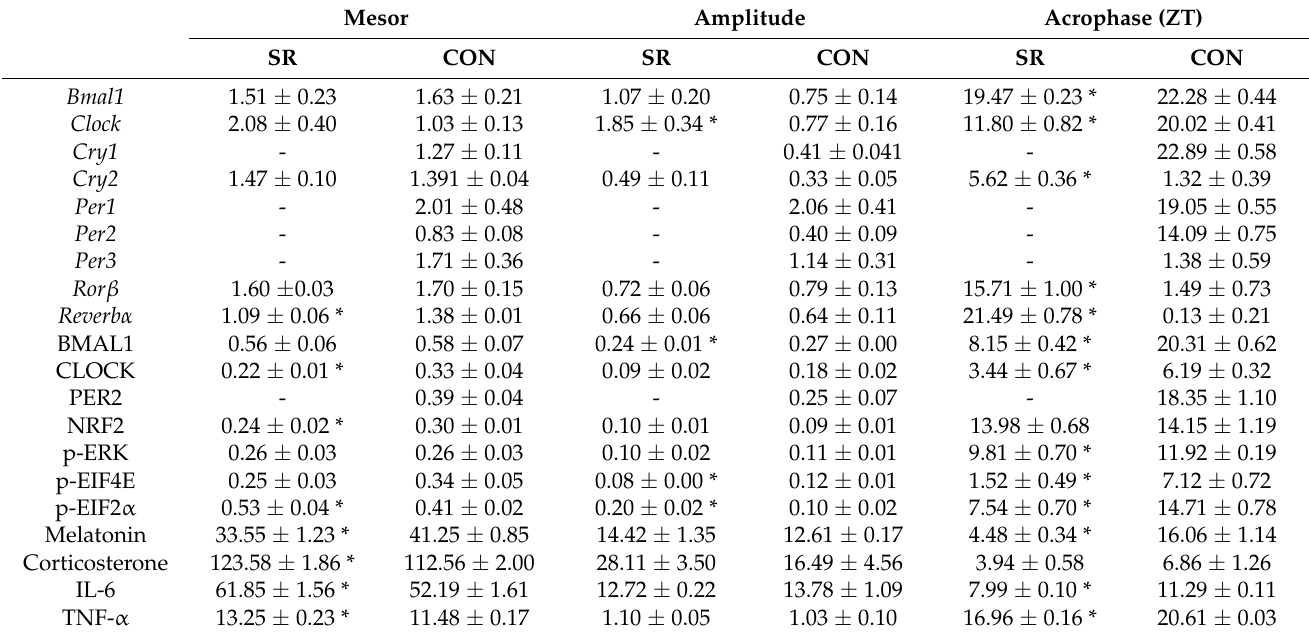
Table 2. Rhythm parameters (mean ± SEM) of genes, proteins, and plasma rhythm output signal in mice under control group and sleep restriction group (14 L:10 D), as determined by cosinor analysis.